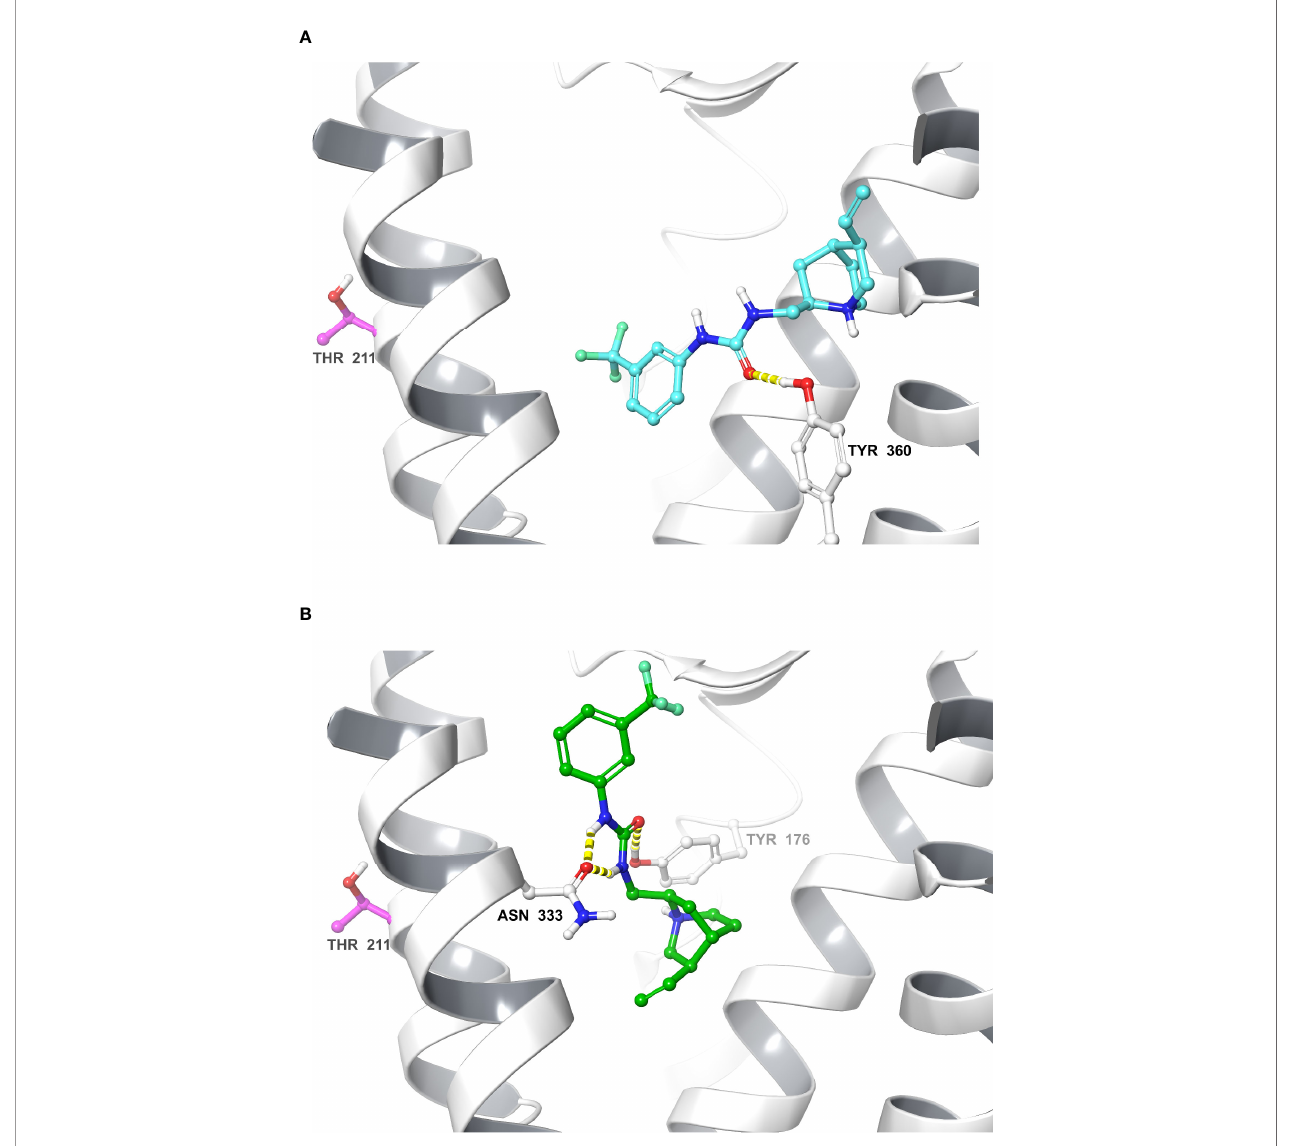
FIGURE 4 | Molecular models of Compound 1 bound to the CCK1R. Shown are molecular models of the docking of Compound 1 to the active CCK1R (11), following removal of the peptide agonist. The two poses depicted represent the two principal converged clusters based on their interaction patterns: the largest cluster (A) , and the cluster containing the highest scoring IFD pose (B) . TM7 and ECL3 ribbons are not displayed for clarity. Interactions are denoted in yellow (hydrogen bond). The residue Thr 211 is represented in